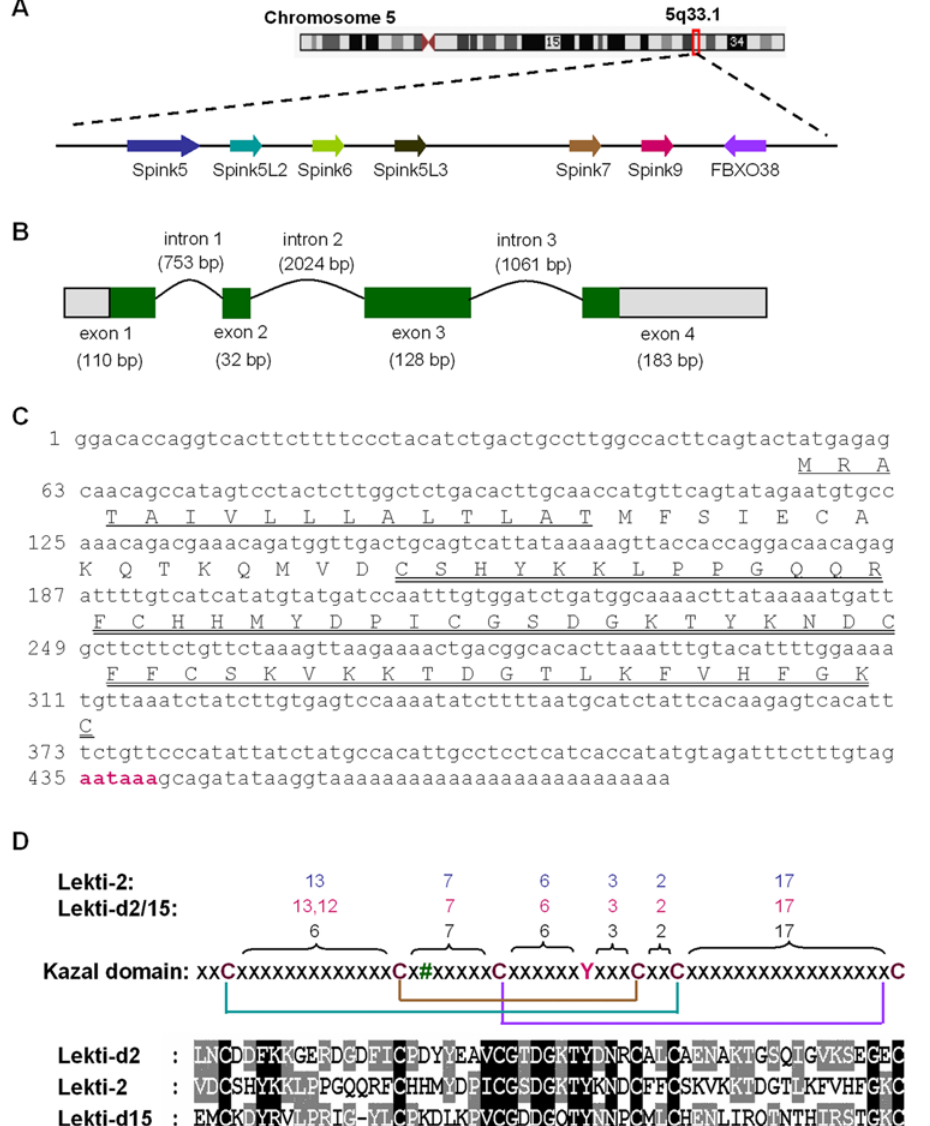
Figure 2. Molecular identification of the Spink9 gene. (A) Schematic physical map of human SPINK genes locus (5q33.1). Genes are ordered from centromere (left hand side) to telomere (right hand side). (B) Schematic diagram of the Spink9 gene, based on its cDNA isolated from foreskin- derived keratinocyte identified by RT-PCR. It consists of four exons and three introns. The positions of the exons (boxes) and introns (curve lines) of Spink9 are deduced by comparing its full-length cDNA sequence with the corresponding genomic DNA. 5 9 /3 9 -UTRs and coding sequences are indicated by gray- and green-filled boxes, respectively. (C) The full-length cDNA sequence of Spink9 and its predicted protein sequence. The N- terminal signal peptide (residues 1–16; underlined) and the Kazal domain (residues 32–86; double-underlined) were detected with the SMART algorithm. The poly(A) signal site was coloured green. (D) Common characteristics of Lekti2 and Lekti. The alignment of the Kazal domains of Lekti-2 and Lekti domains 2 and 15 were generated by using M-COFFEE, displayed by using GeneDoc and shown in the down panel. The middle panel shows a schematic pattern of the typical Kazal domain including conserved tyrosine residue ( Y ) and disulfide bonds [14]. # represents the residue at the P1 site. The residue numbers spacing the cysteine residues are indicated on the top panel for the Kazal domain, LEKTI-2 and the LEKTI domains 2 and 15, respectively.